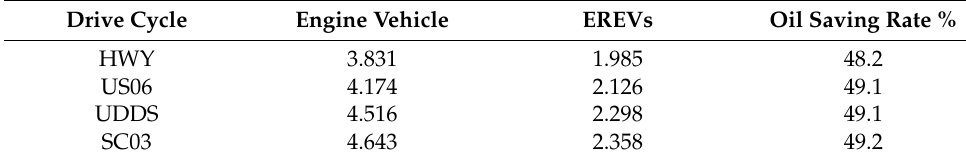
Table 1. Fuel consumption results of different driving cycles (L/100 km).